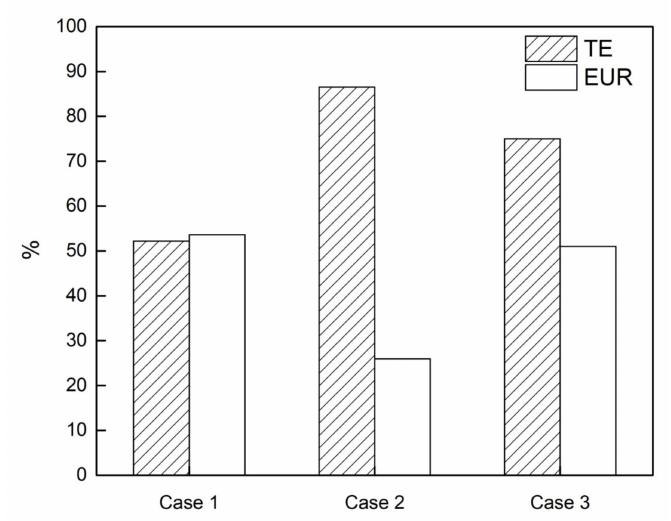
Figure 6. Comparison of flue gas waste heat thermal efficiency and exergy utilization rate in three